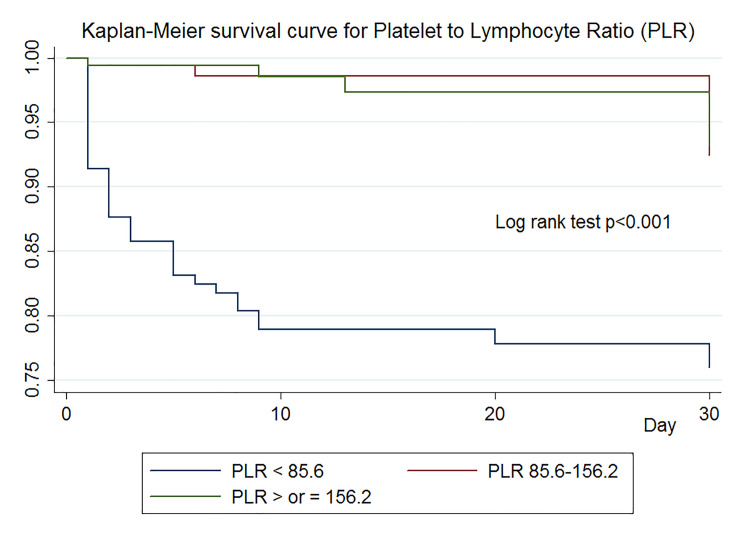
Kaplan-Meier survival curves according to tertiles of platelet-to-lymphocyte ratio (PLR).